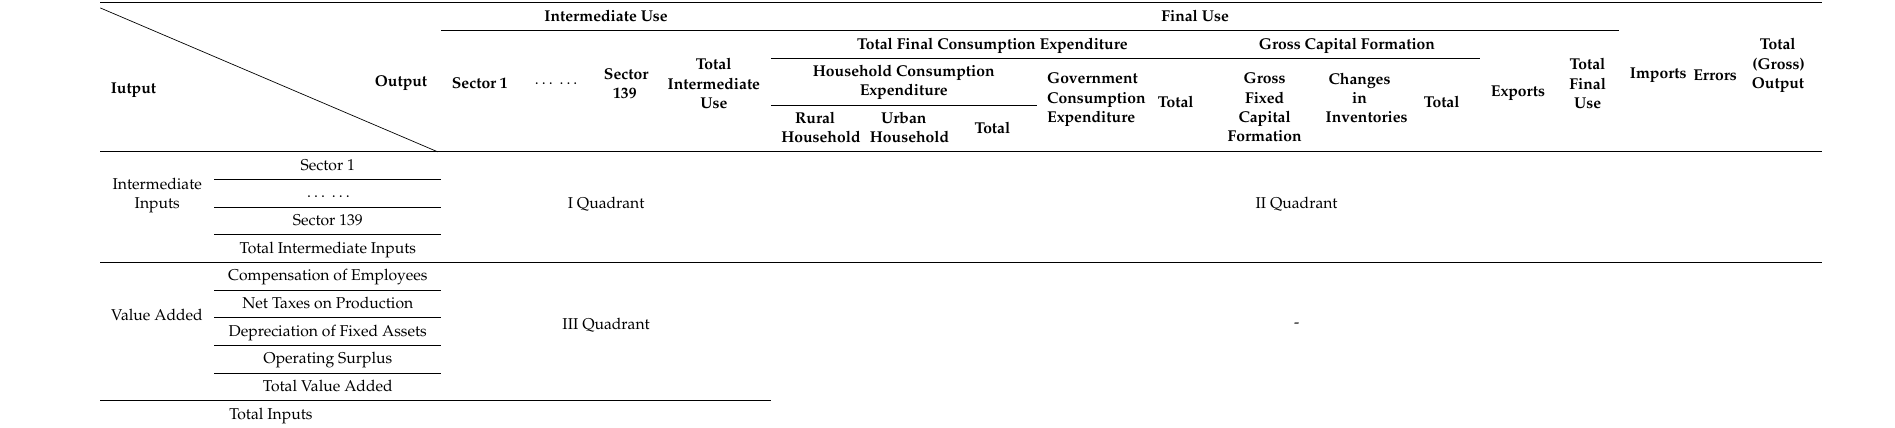
Table 1. Basic input-output table